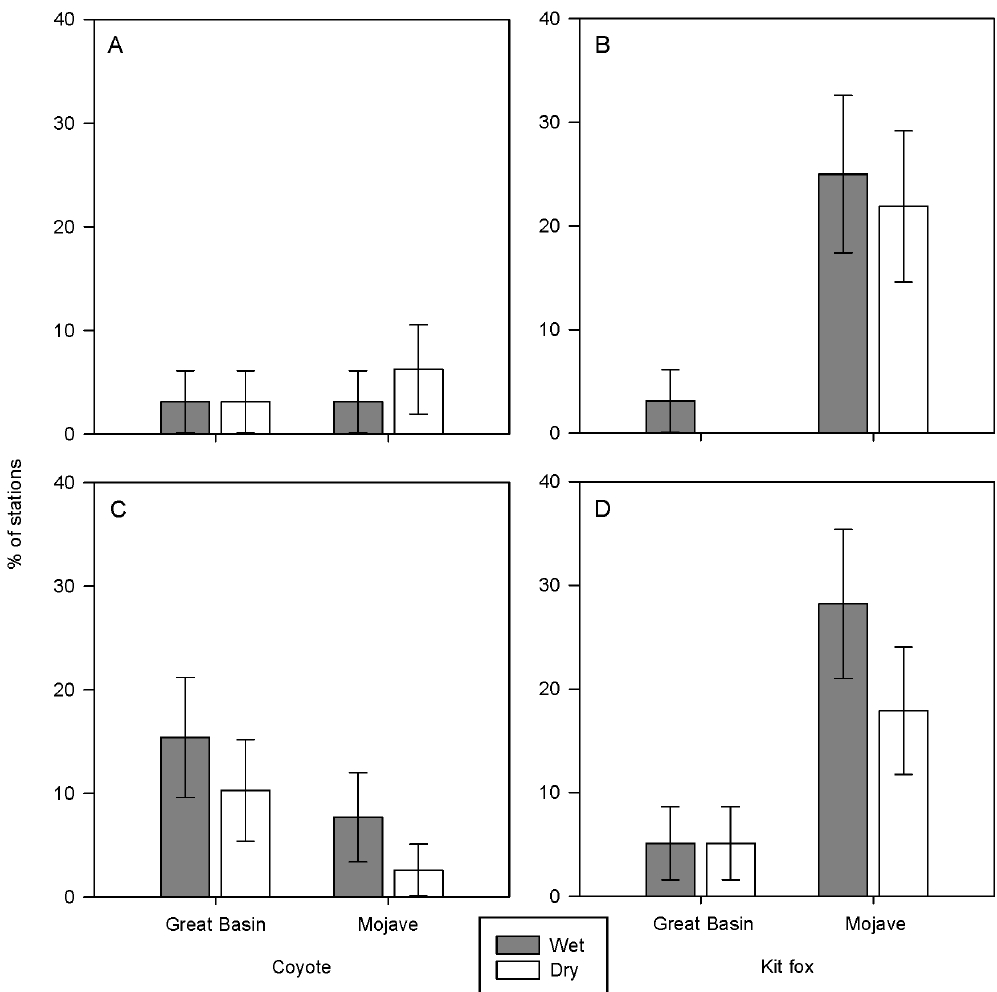
Figure 3. Proportions ( 6 SE) of scent stations visited by canids in wet and dry areas in A) 2011 and B) 2012. Stations in wet areas were # 2.6 km from free water (mean=1.25 km) whereas stations in dry areas were $ 2.6 km from free water (mean=4.17 km). Data were collected on coyotes ( Canis latrans ) and kit foxes ( Vulpes macrotis ) in the Great Basin and Mojave Deserts, USA.